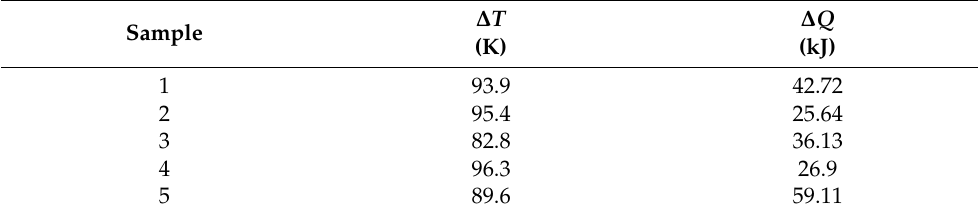
Table 6. The ∆ T and ∆ Q values of the materials tested.